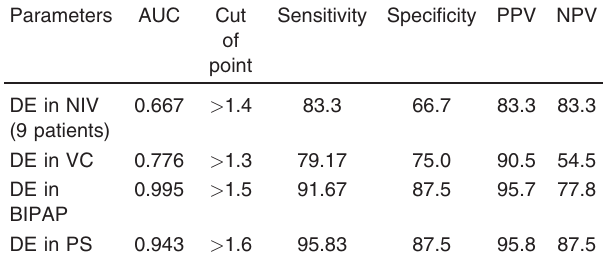
Table 4 Receiver operating characteristic for diaphragmatic excursions in each mode of mechanical ventilation as predictors of successful weaning Parameters